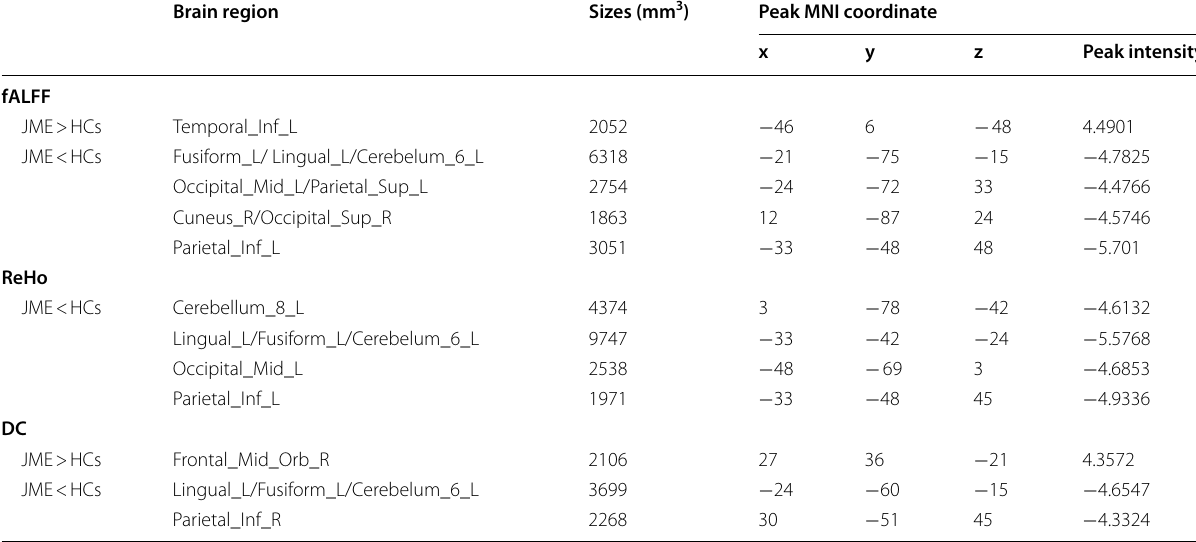
Table 2 Regions showing abnormal fALFF, ReHo, and DC in with JME and healthy controls Brain